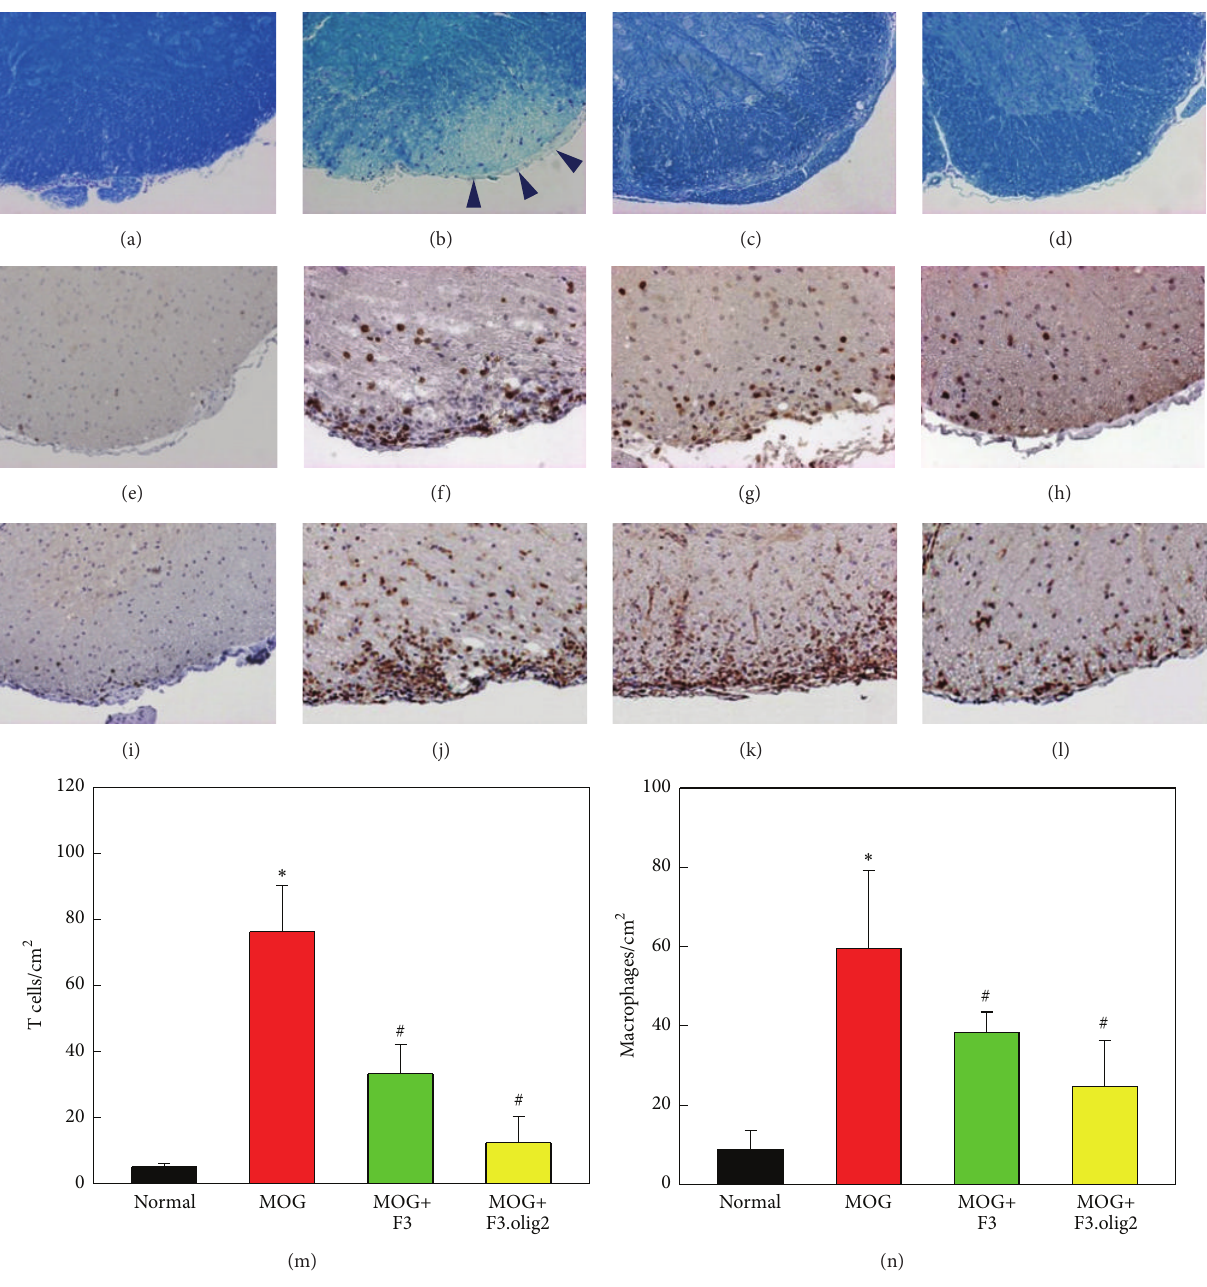
Figure 2: Representative findings of the spinal cords stained with Luxol fast blue ((a)–(d)) and immunostained with CD3 for T cells ((e)– (h)) or Mac3 for macrophages ((i)–(l)) and the numbers of T cells (m) and macrophages (n). (a), (e), and (i): normal, (b), (f), and (j): myelin oligodendrocyte glycoprotein (MOG) alone, (c), (g), and (k): MOG+F3 cells, and (d), (h), and (l): MOG+F3.olig2 cells; arrowheads: demyelinated area. ∗ Significantly different from normal control ( 𝑃 < 0.05 ). # Significantly different from MOG alone ( 𝑃 < 0.05